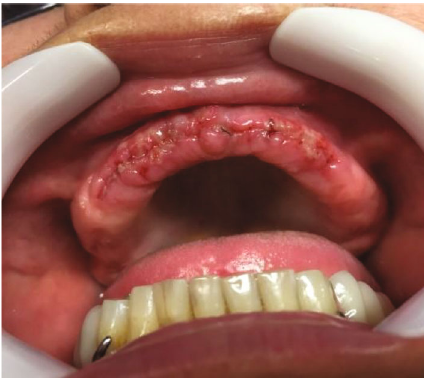
Figure 1: 7-day postoperative period. Image used for analyzing